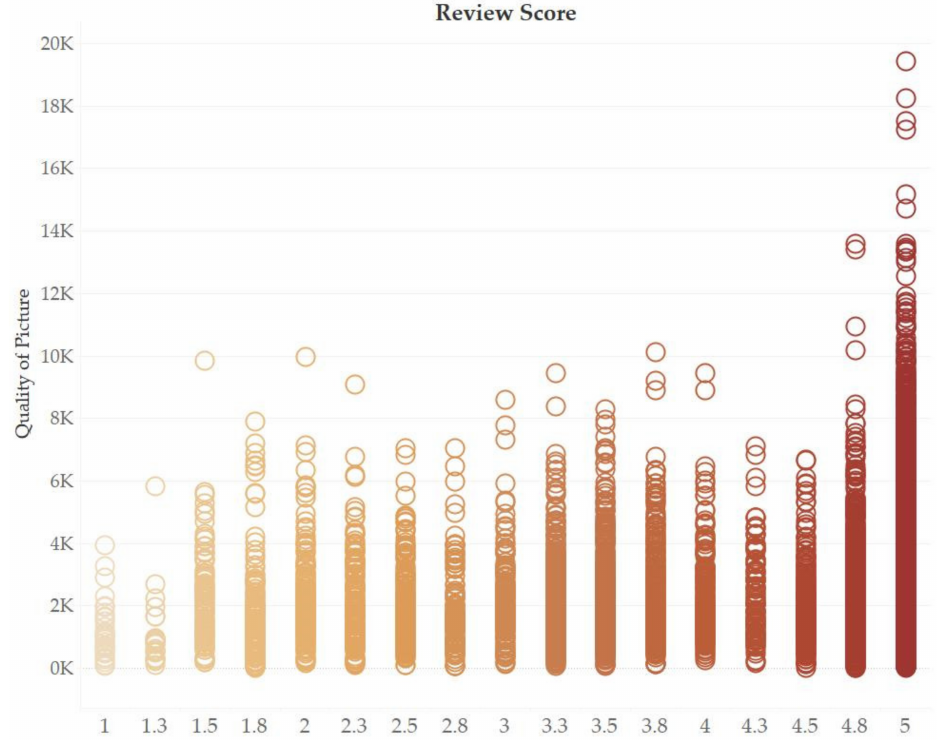
Figure 5. The relationship between review scores and the quality of